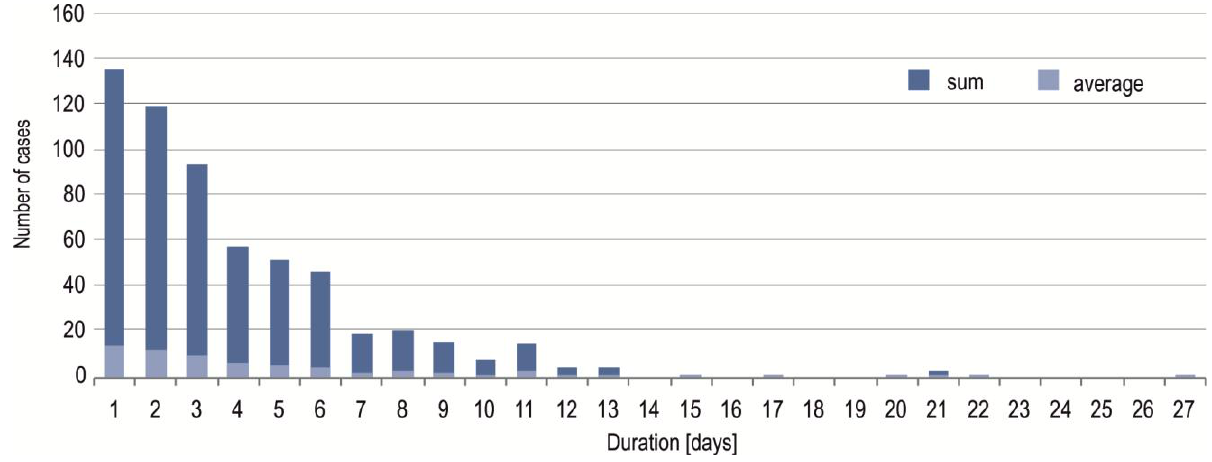
Fig. 5. Number of sequences of days with atmospheric fronts in Poland in the period 2006-2015